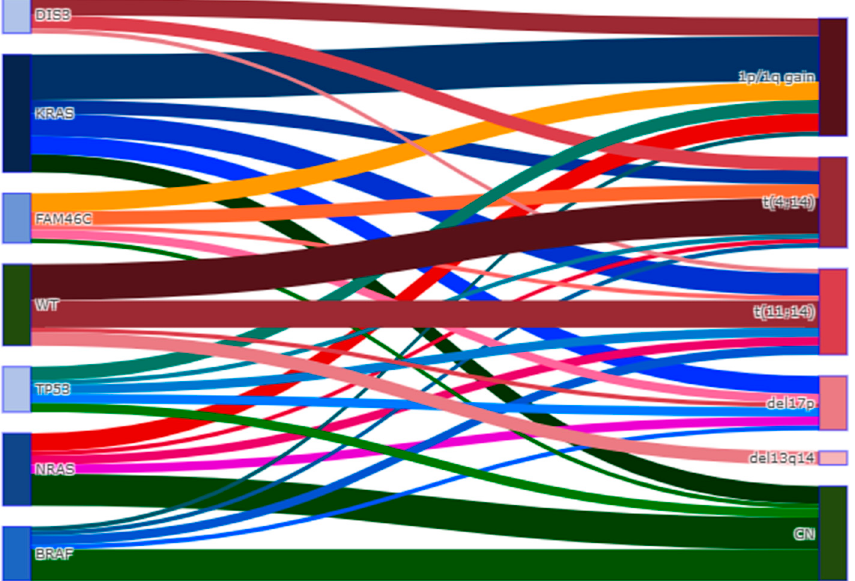
Figure 3. Sankey diagram showing the relationships between the six most frequently mutant genes DIS3 , KRAS , FAM46C , TP53 , NRAS and BRAF ( left ) and the cytogenetic characteristics ( right ), in patients with relapsed or refractory multiple myeloma.